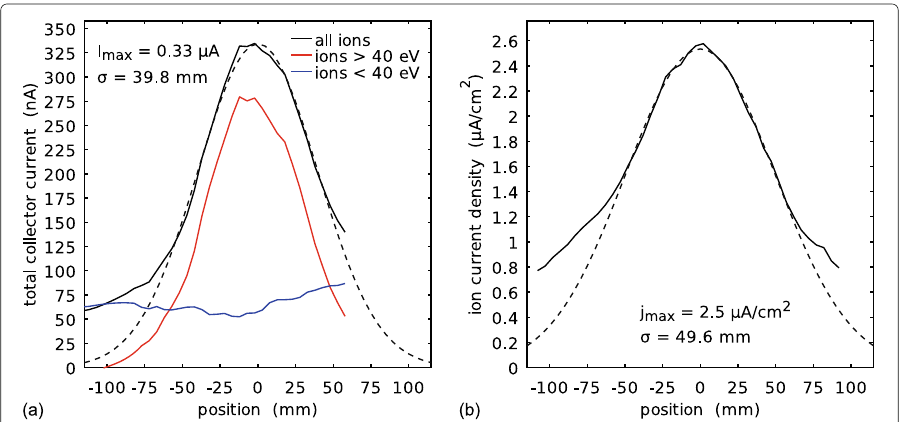
Fig. 13 The calibration of the RPA is done by means of Faraday cup measurements. (a) RPA measurements and (b) corresponding Faraday cup measurements. The I max , j max and σ values refer to the maxima and standard deviations of the Gaussian fits (dashed black curves) to the black curves,